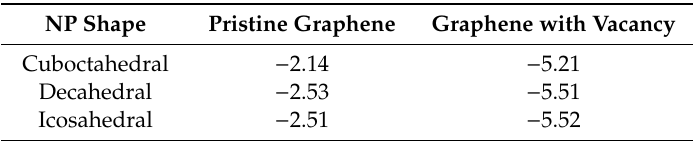
Table 2. The binding energies (eV) of the Au 561 NPs are oriented with a vertex on pristine graphene and on a graphene vacancy.